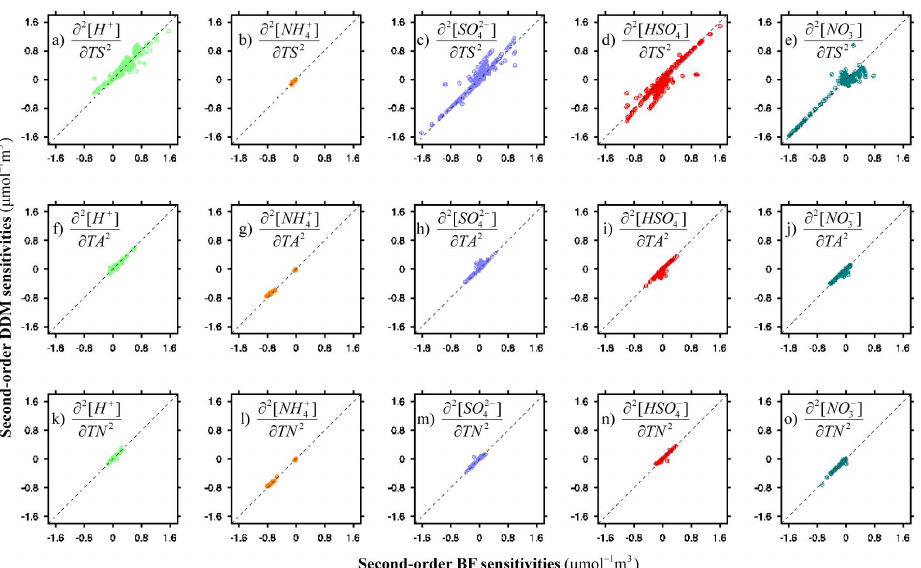
) , HSO − , and NO − 4 4 3